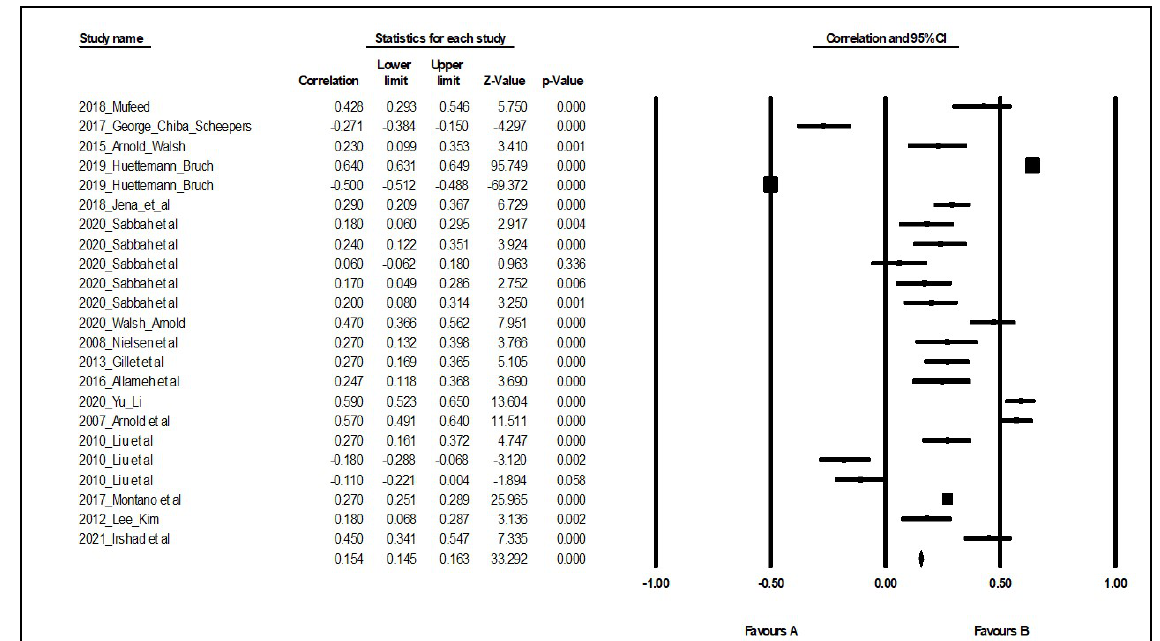
Figure 3. Forest plot of studies included in the quantitative analysis [11,16,20,23,47–57].